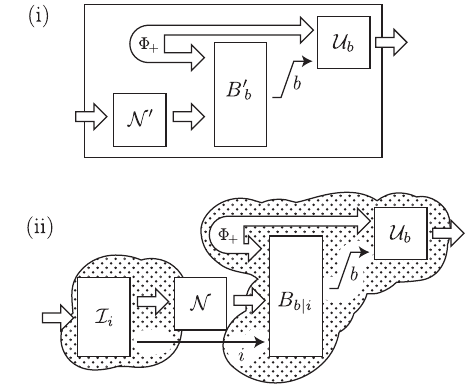
FIG. 6. (i) To correct the effect of the Bell measurement and the preparation of a maximally entangled state, it is sufficient to apply a unitary correction selected using the outcome of the Bell measurement. The resulting channel (bigger box) is equivalent to N 0 . (ii) As seen in Fig. 5, the same correction can be applied when using N to recover N 0 . In the dotted blob, we show the parts of the protocol that are regrouped to form a free trans- formation Λ as defined in Sec.